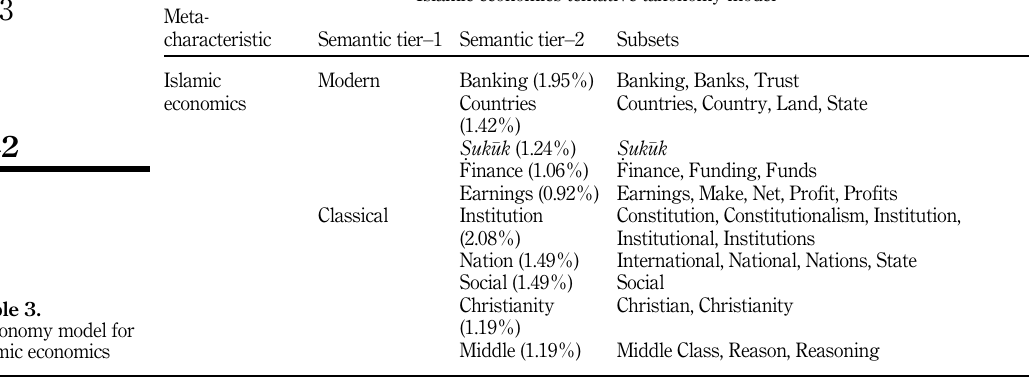
Table 3 elaborates 474 keywords taken from 111 journal articles. The most frequent keywords explaining Modern Theories are “ Banking ” , “ Countries ” , “ S “